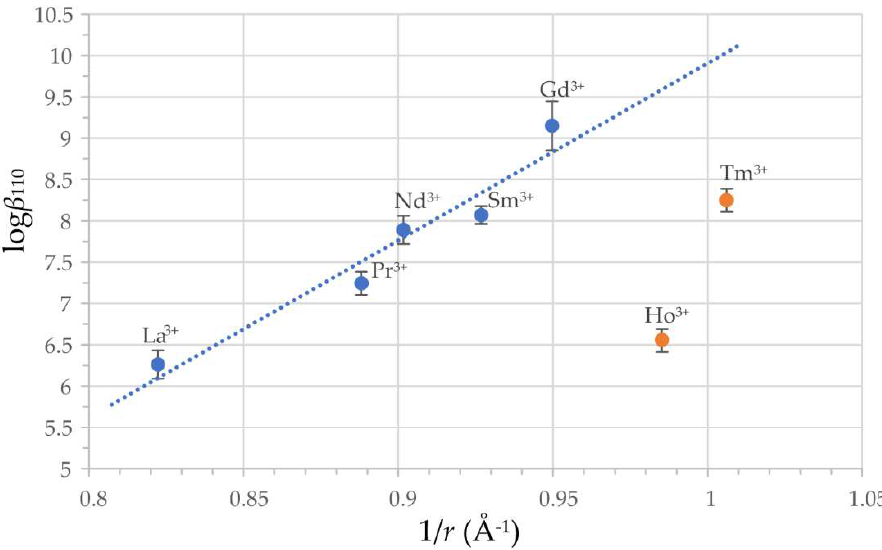
Figure 5. Correlation of formation constants β 110 for reaction Ln 3+ + L 2- ⇋ LnL + from Table 3 and reference [31] with the reciprocal of ionic radius (i.e., r − 1 ) of Ln 3+ cations: La 3+ ( r = 1.216 Å), Pr 3+ ( r = 1.126 Å), Nd 3+ ( r = 1.109 Å), Sm 3+ ( r = 1.079 Å), Gd 3+ ( r = 1.053 Å), Ho 3+ ( r = 1.015 Å), Tm 3+ ( r = 0.994 Å) [34]. Dotted line is a least squares regression line (R 2 = 0.94), trough points representing La 3+ , Pr 3+ , Nd 3+ , Sm 3+ , and Gd 3+ (blue dots) and error bars represent three-times the estimated standard deviation (3 σ ) of log β 110 . Orange dots representing Ho 3+ and Tm 3+ are considered